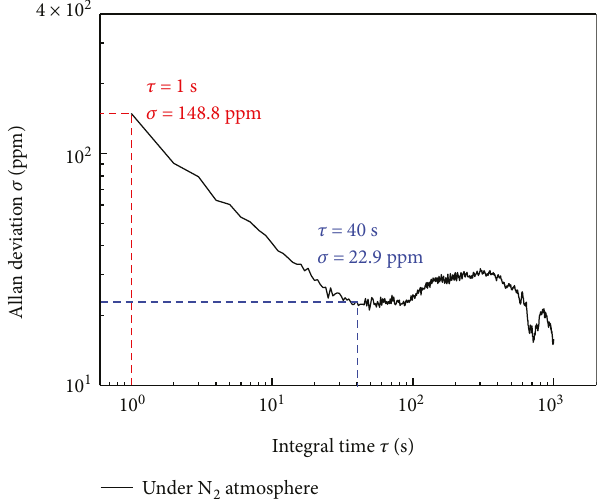
Figure 10: The Allan deviation curve of the detection system.